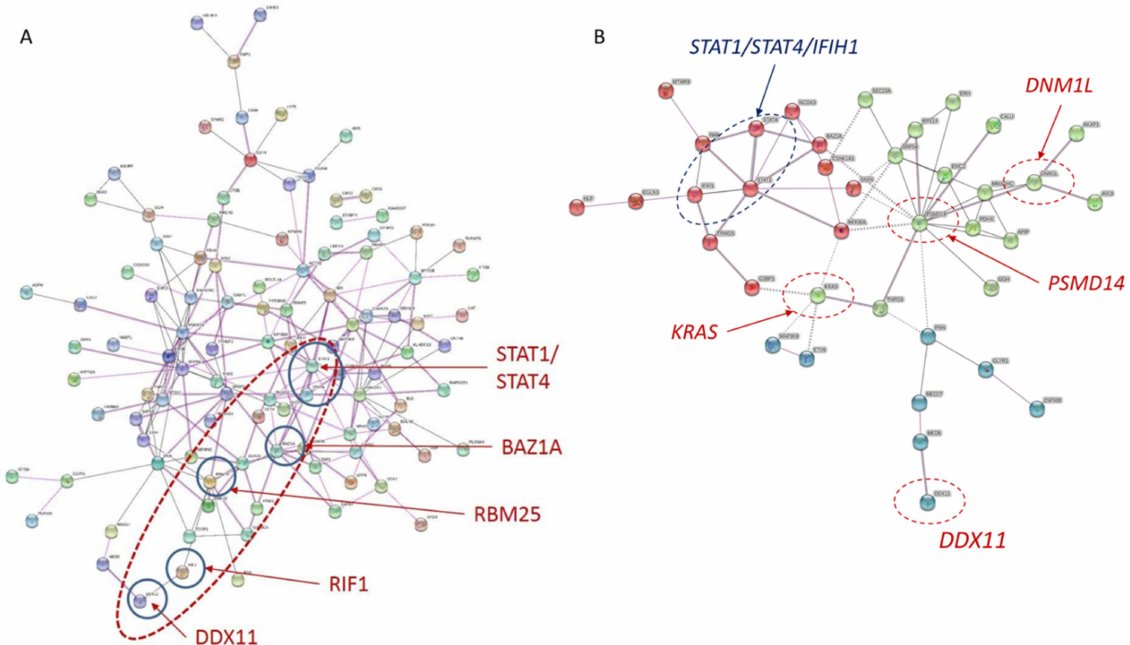
Figure 3. Protein network analysis. STRING protein network analysis of 187 unique genes ( A ) that have significant changes in expression in six GEO datasets and are located in the 30 SLE loci. STRING analysis of 55 genes ( B ) having significant differential expression in at least two GEO datasets and with their expression directionally aligned. DNM1L and KRAS were included in this interaction network ( B ) and cluster analysis was performed using k-means. A minimum interaction score of 0.15 was chosen for either coexpression or experimental